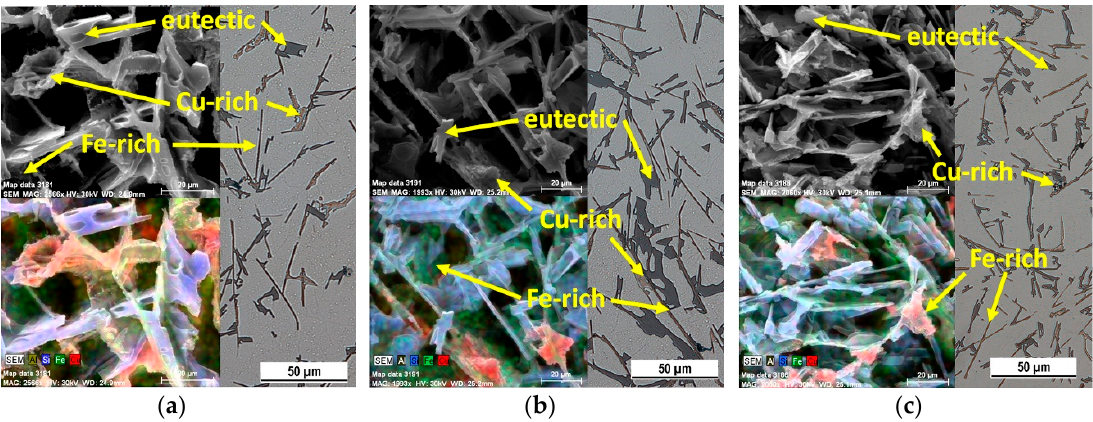
Figure 4. Microstructure of AlSi9Cu3 alloy depend on the ratio of returnable material in the batch after natural aging, SEM; ( a ) 20–80 alloy, ( b ) 50–50 alloy, ( c ) 90–10 alloy.